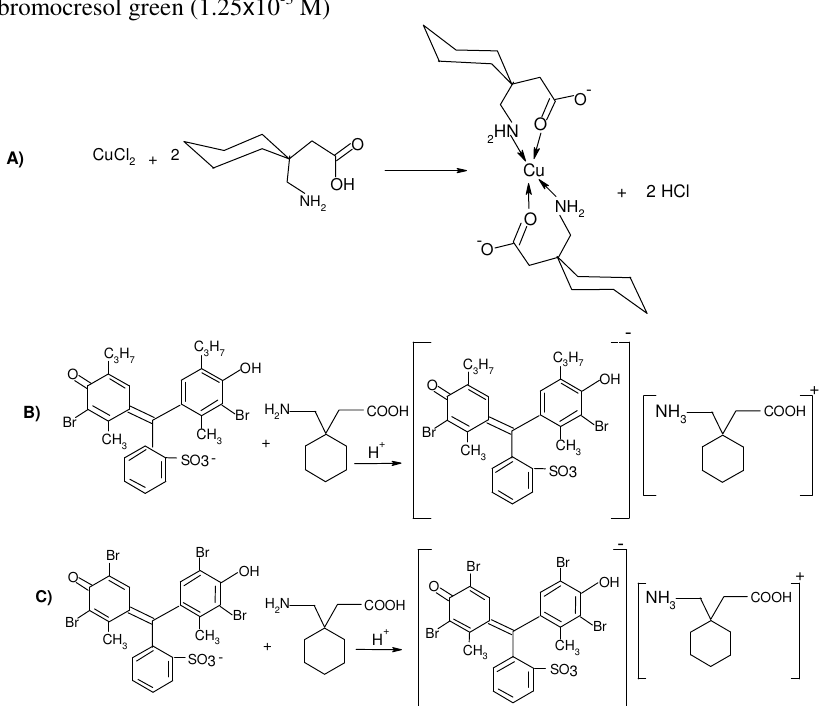
Figure 13. Determination of the stoichiometry of the reaction of gabapentin (1.25 x 10 -3 M) and bromocresol green (1.25 x 10 -3